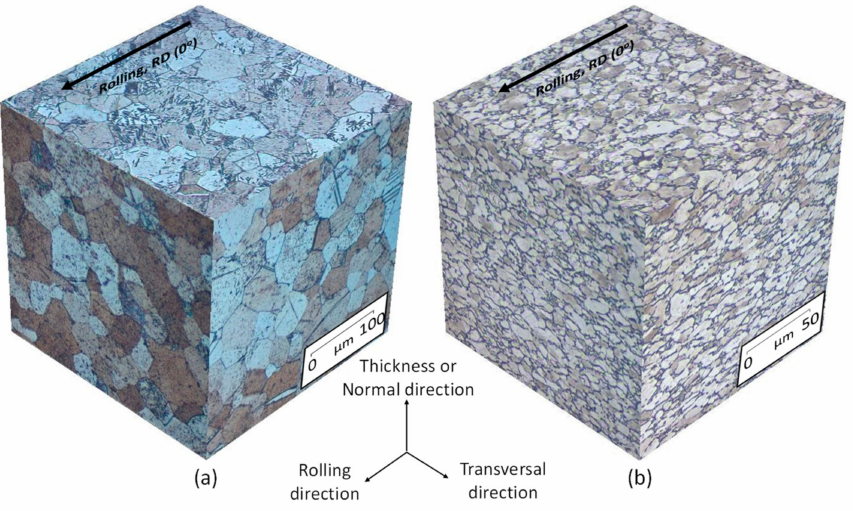
Figure 1. As-received micro-structure considering the different directions respect to rolling one. ( a ) α -phase of Ticp2 (200 × ); ( b ) α + β phases of Ti6Al4V (400 × ).